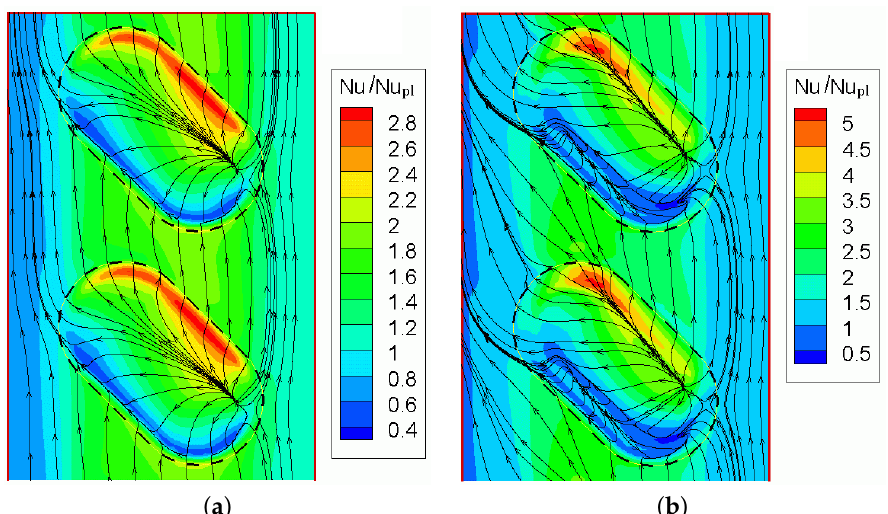
Figure 17. Comparison of relative Nusselt number fields on the lower wall of the dimpled channel with plotted spreading patterns for depths of 0.1 ( a ) and 0.2 ( b ).